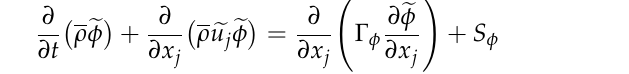
Figure 2. Meshing of the computational domain .